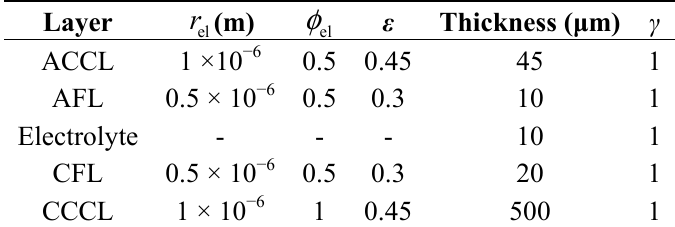
Table 4. Micro structure parameters and thickness of each layer